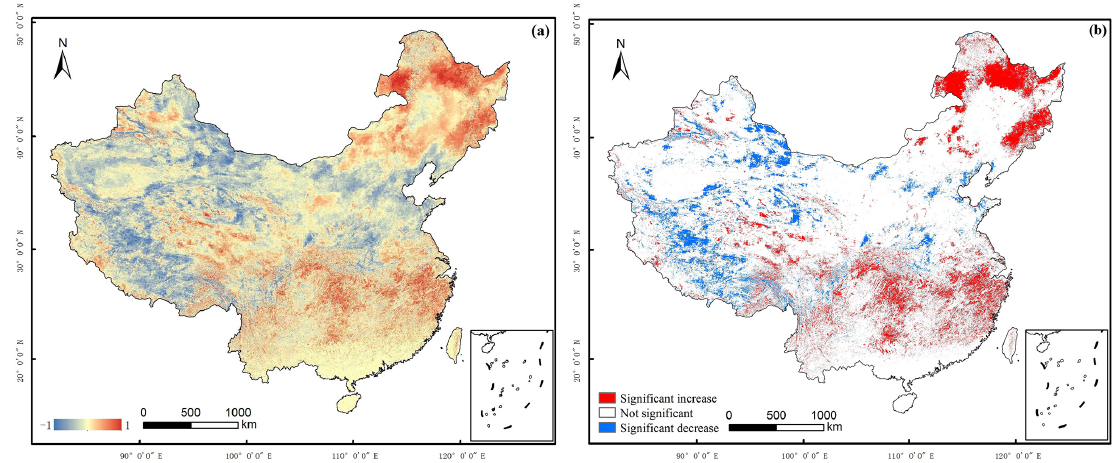
Figure 5. Variation in the average annual SCDs in China based on the Mann–Kendall method from 2001 to 2014. (a) Variation in the annual SCDs; (b) significance of the variation in the annual SCDs.